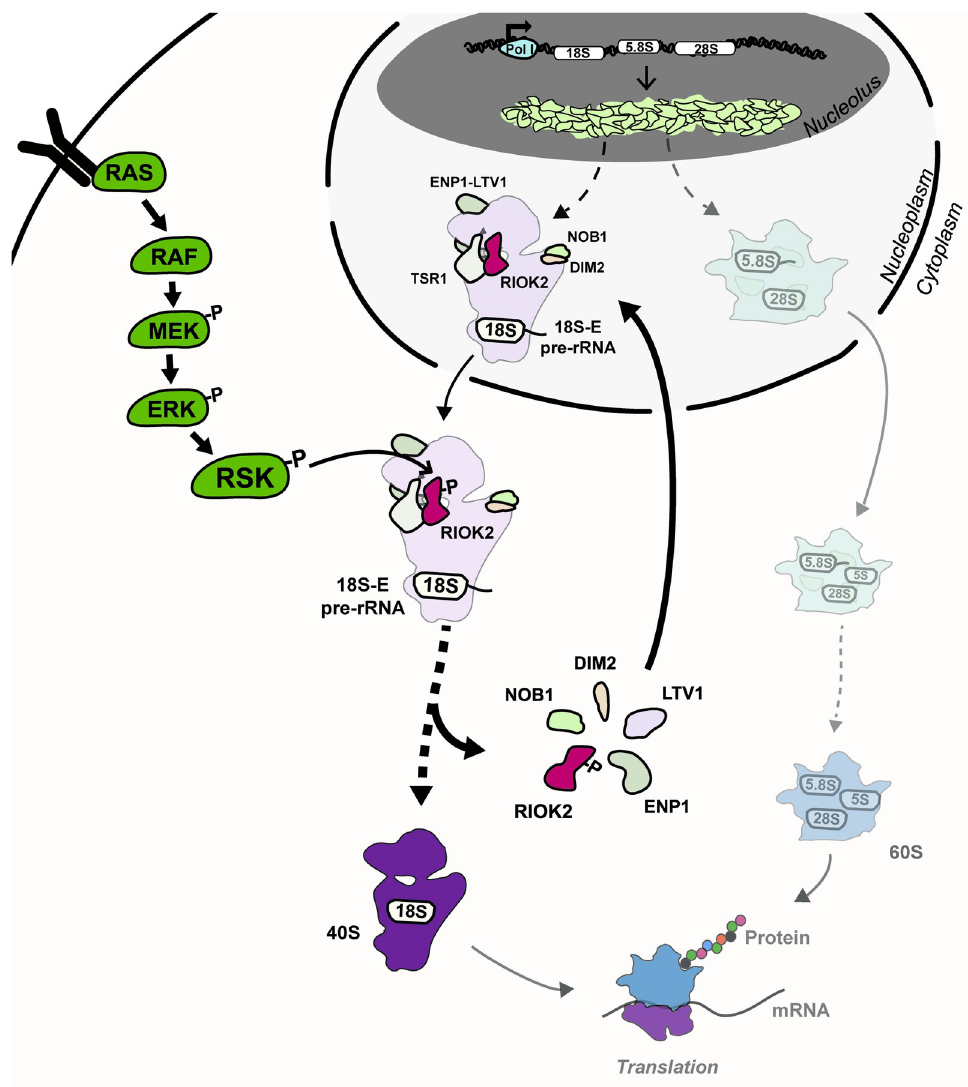
Fig 7. RIOK2 phosphorylation at Ser483 by RSK facilitates late stages of pre-40S particle maturation. RIOK2 is incorporated into pre-40S particles in the nucleus and participates to their export to the cytoplasm. Phosphorylation of RIOK2 by RSK at Ser483 facilitates its dissociation from pre-40S particles, which allows simultaneous or subsequent dissociation of other factors (ENP1, LTV1, DIM2, NOB1) to promote efficient maturation of the 18S-E pre-rRNA. This phosphorylation event is required for optimal protein synthesis and cell